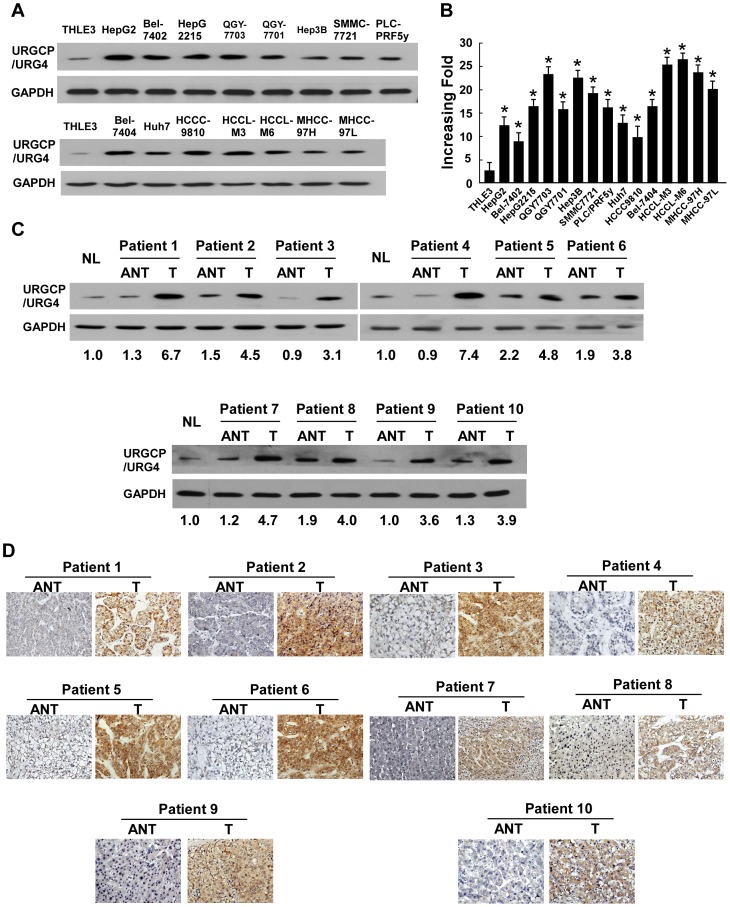
URGCP/URG4 is elevated in HCC.Expression of URGCP/URG4 protein (A) and mRNA (B) in normal human liver epithelial cells (THLE3) and cultured HCC cell lines QGY-7703, QGY-7701, SMMC-7721, HepG2, Hep3B, PLC/PRF/5, HuH7, HepG-2215, HCCC-9810, Bel-7402, Bel-7404, HCCLM3, HCCLM6, MHCC97L and MHCC97H. GAPDH was used as a loading control. Western blotting (C) and IHC (D) analysis of URGCP/URG4 protein expression in each of the tested primary HCC tissues (T) and adjacent non-cancerous tissues (ANT) taken from the same patient. Error bars represent SD from three independent experiments. *P<0.05.